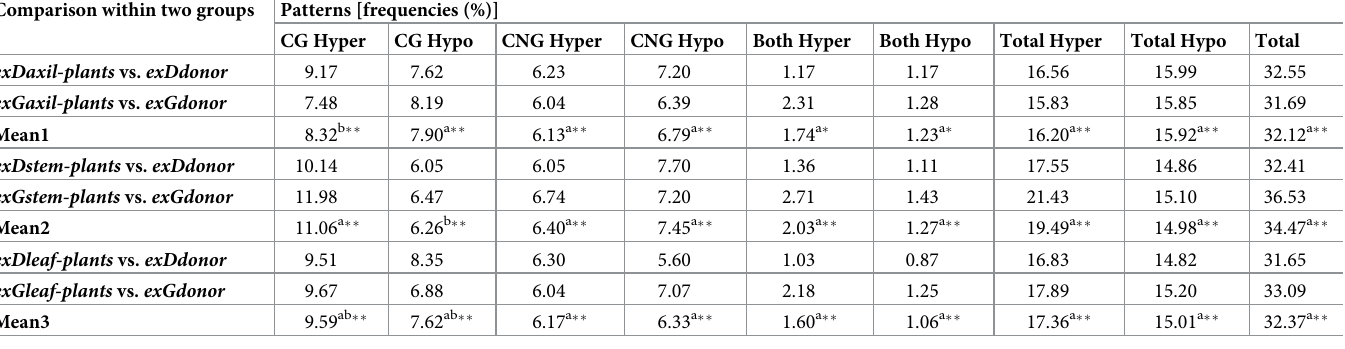
plants from axillary buds. In total, neither methylation level SV or locus-specific MSV of L . ruthenicum showed a simple reduction after acclimatization because there was not only decrease but also increase, however, the decrease was predominant. All the patterns of locus-specific methylation alterations in leaves of various micropropa- gated plants ex vitro versus the corresponding in vitro leaves of the same plants were found to be statistically significantly. However, the total locus-specific methylation alterations in the two donors (44.24%) were the sharpest (S2 Table), which indicated that donors and micropro- pagated plants did not show the identical response to acclimatization. For all the three types of micropropagated plants, the rates of CNG Hypo and Total in plants from stem calli were the highest (S2 Table). This might account for why the significant methylation level alterations in